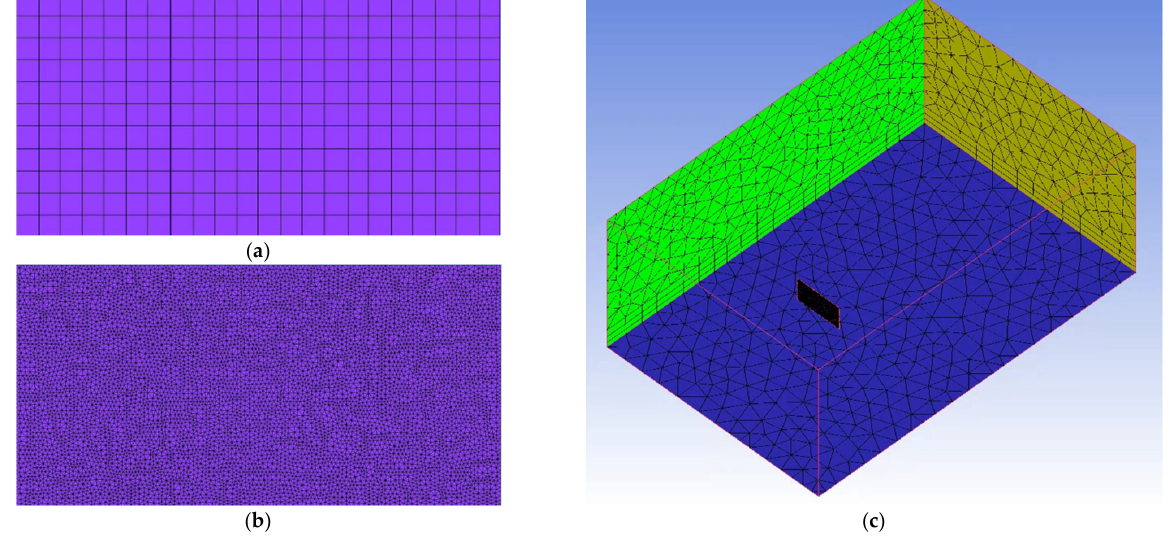
Figure 3. Different mesh types are employed: ( a ) hexahedral surface meshing of the standard sign panel, ( b ) tetrahedral meshing of the standard sign panel, and ( c ) tetrahedral surface meshing of the whole domain (coarse).